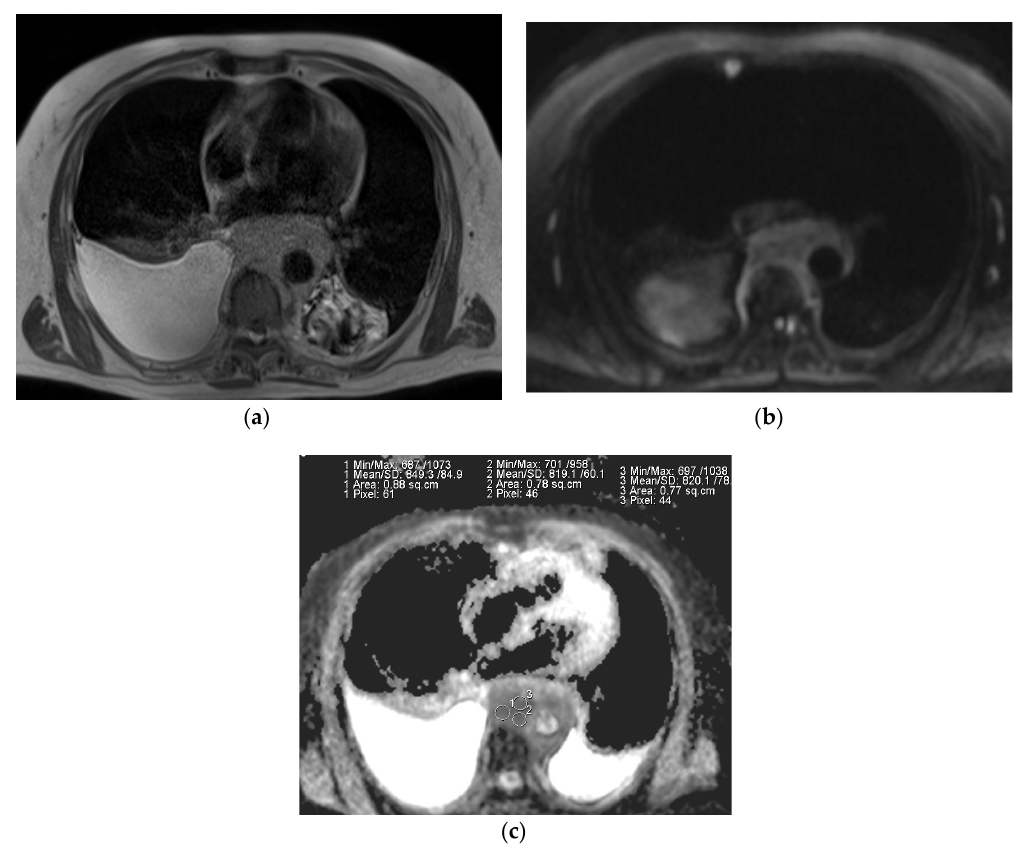
Figure 2. ( a ) T2-weighted axial MRI of a 75-year-old male shows a T2 homogeneous signal in enlarged lymph nodes encasing descending thoracic aorta; ( b ) Diffusion-weighted axial MRI shows diffusion restriction in most of the lymph node; ( c ) System generated ADC map of corresponding lymph node shows ADC mean value of 0.829 × 10 − 3 mm 2 /s. The final pathological diagnosis was